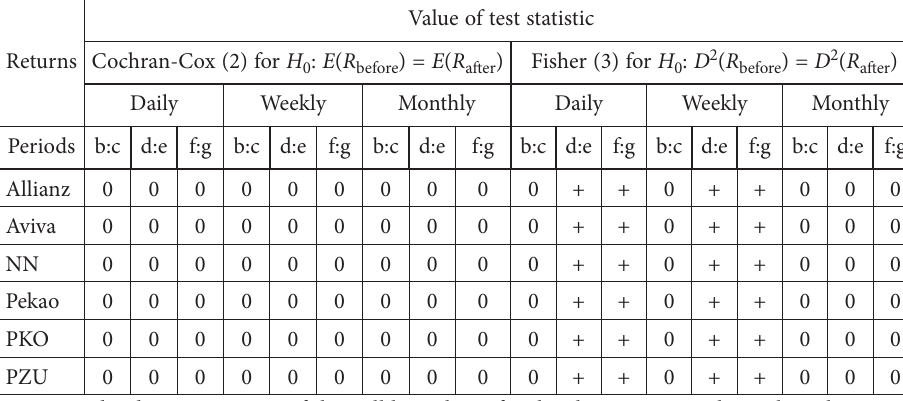
Table 9. Decisions based on statistics (2), (3) for returns and variances of pension funds in the pairs of periods (source: own calculations) Value of test statistic Returns Cochran-Cox (2) for H 0 : E ( R before ) = E ( R after ) Fisher (3) for H 0 : D 2 ( R before ) = D 2 ( R after ) Daily Weekly Monthly Daily Weekly Monthly